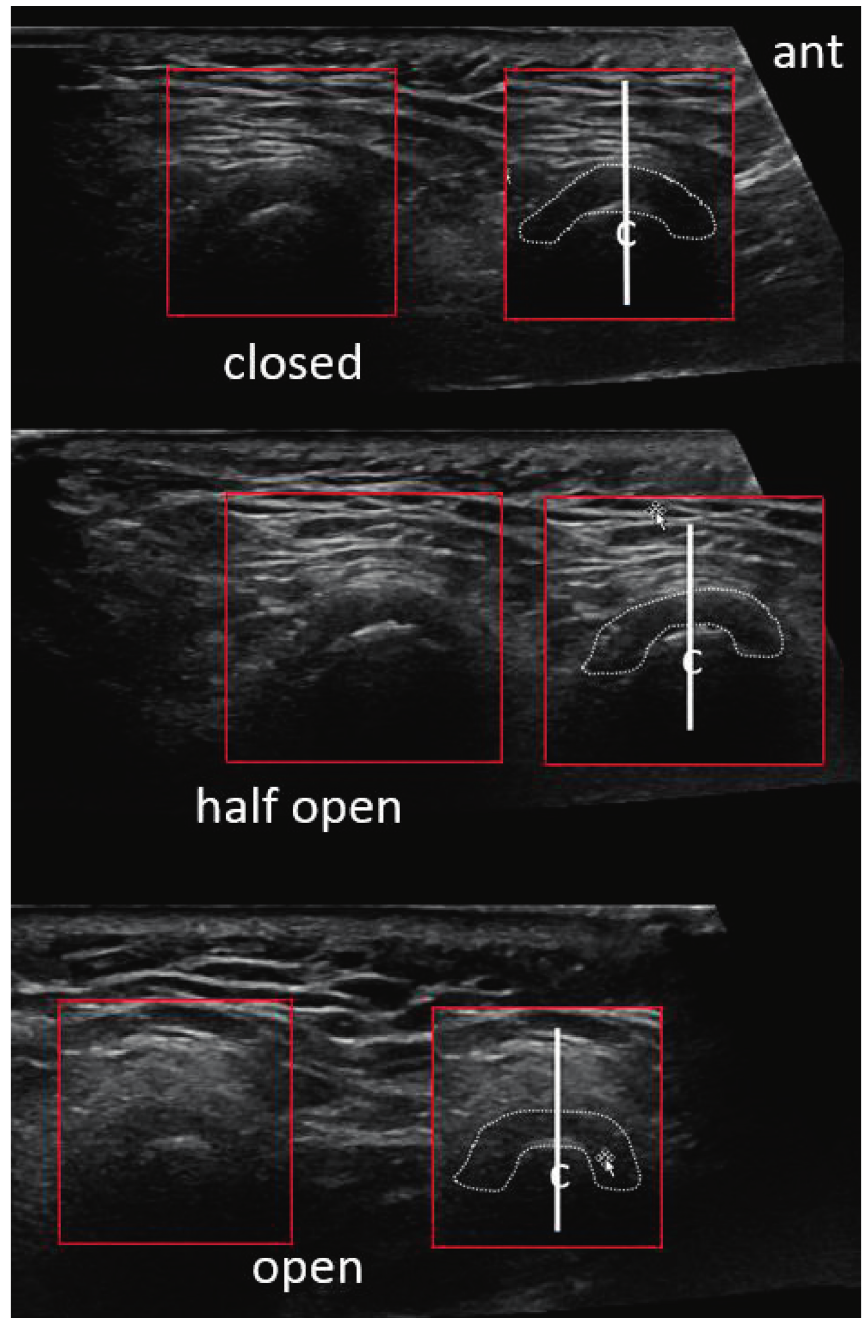
Figure 3: Normal ultrasound appearance of the articular disc in the sagittal plane, seen as an inverted hypoechoic c-shaped structure. Note that the disc maintains a constant central appearance with respect to the centre of the condyle, “c,” outlined by a central vertical line during the closed-mouth, half-open-mouth, and fully-open-mouth views. The anterior (“ant”) band and posterior band of the articular disc appear symmetrical in size with respect to the centre of the condyle. A focal annotated view was provided to aid visualization with the articular disc outlined with a dotted